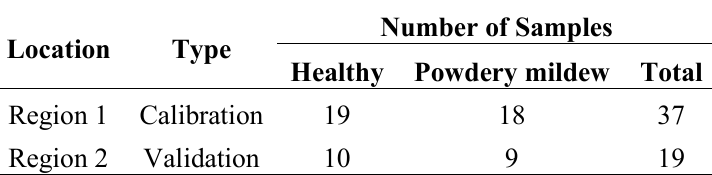
Table 2. Basic information for disease survey experiment.